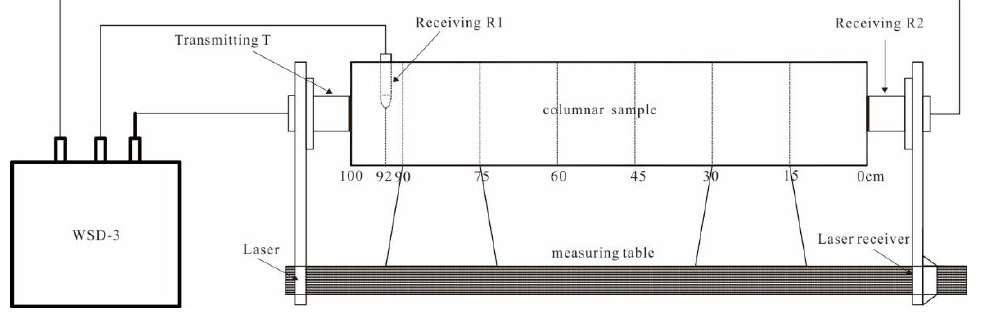
Figure 2. Coaxial differential distance measurement